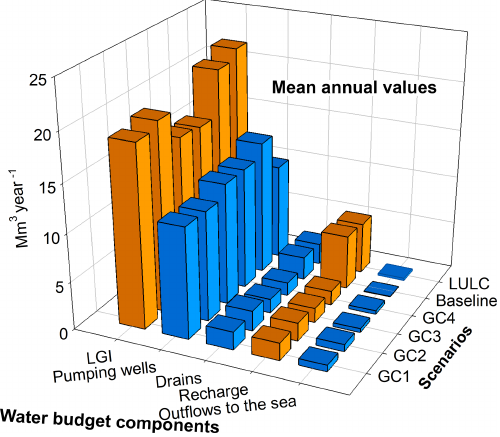
Figure 13. Mean inflows and outflows for various global scenar- ios